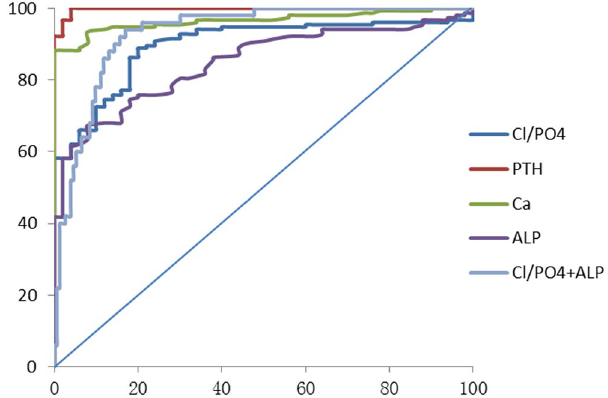
Figure 2. Receiver-operating characteristic curves used for predicting hypercalcaemia of PHPT and comparison of the ROC curves. Note: PTH, ROC-AUC = 0.998 (95% CI, 0.000–1.000), calcium, ROC- AUC = 0.966 (95% CI, 0.943–0.989), Cl/PO 4 , ROC-AUC = 0.897 (95% CI, 0.851–0.942), ALP, ROC- AUC = 0.848 (95% CI, 0.795–0.901), Cl/PO 4 + ALP, ROC-AUC = 0.932 (95% CI, 0.897–0.966) between hypercalcaemia and normal